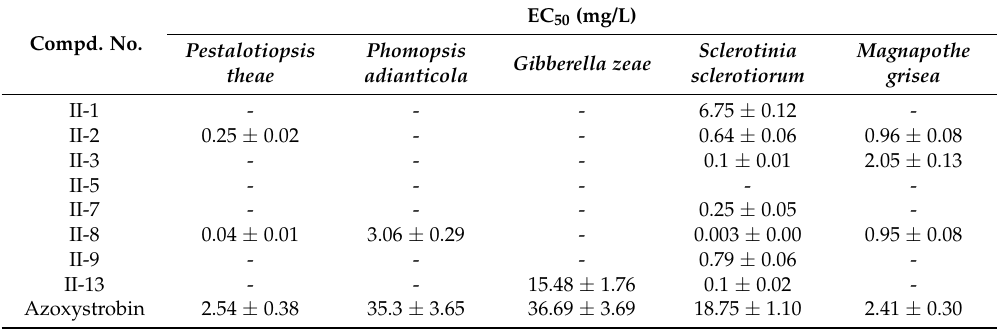
Table 3. The EC 50 values of the selective compounds against several strains of fungi.